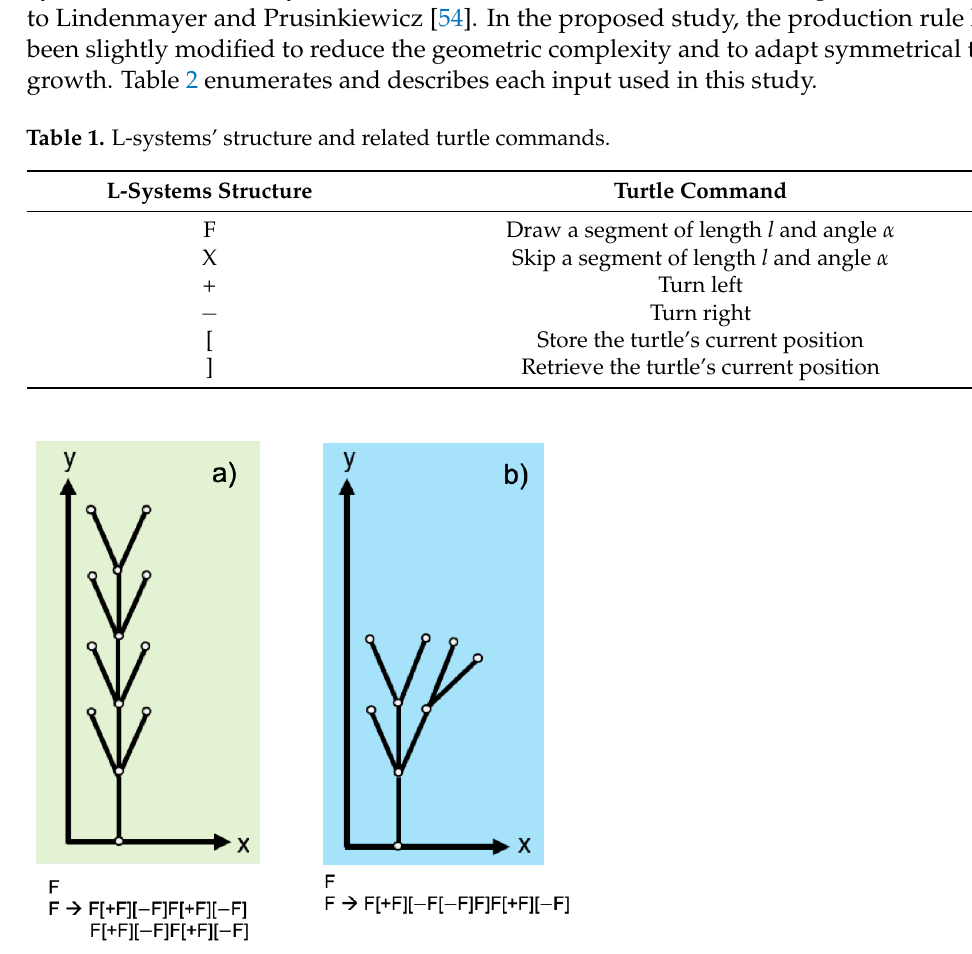
Table 2. Grammar of the L-systems used in the biomimetic design method.